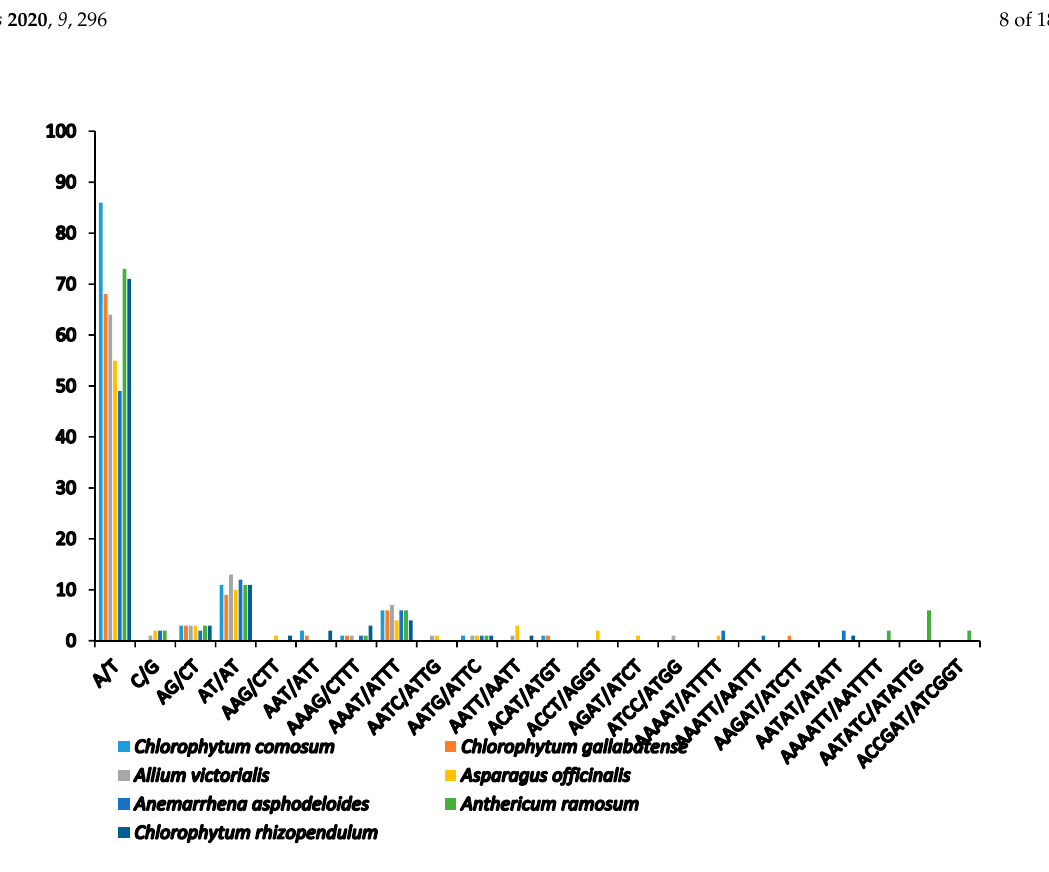
Figure 4. Number of different repeat units of SSRs.